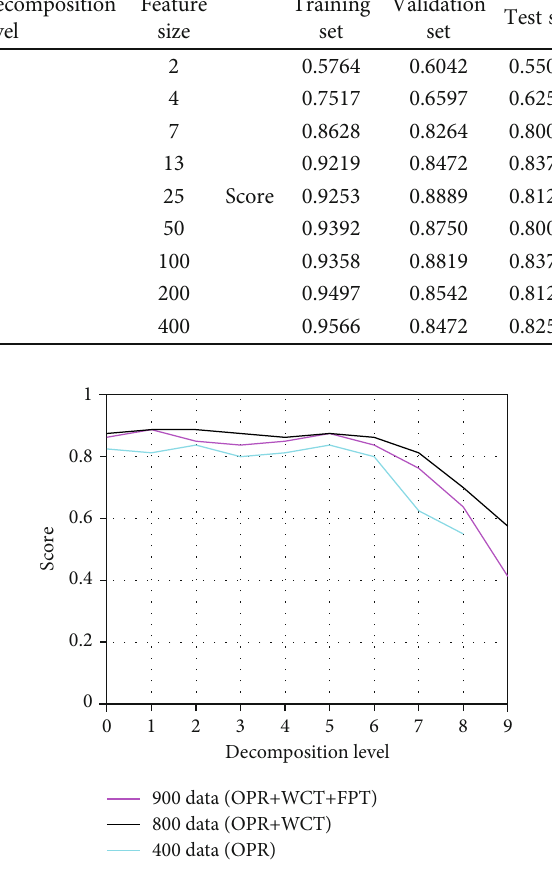
Figure 8: Test set scores of decomposition level depending on the number of raw data: the 400, 800, and 900